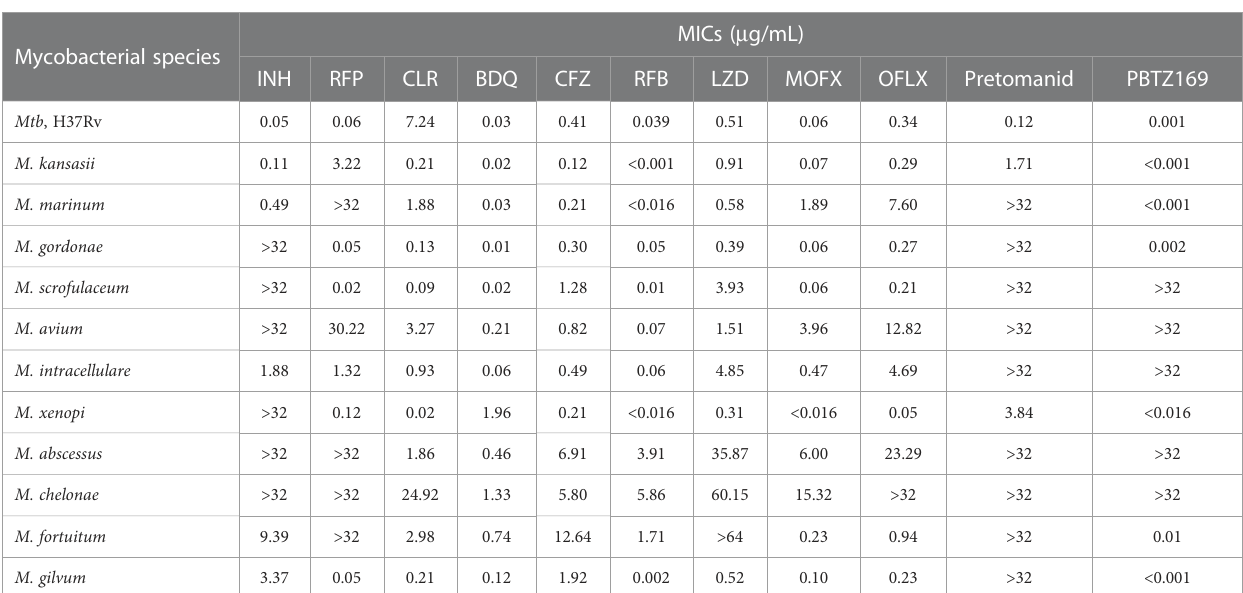
TABLE 1 MICs of 11 drugs (or compound) against different mycobacterial species.